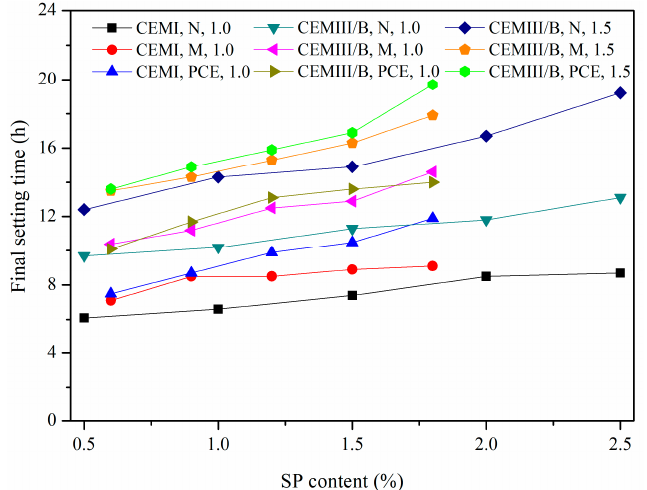
Figure 11. Final setting times of fresh SMCG with different SP, cement type and W/S.